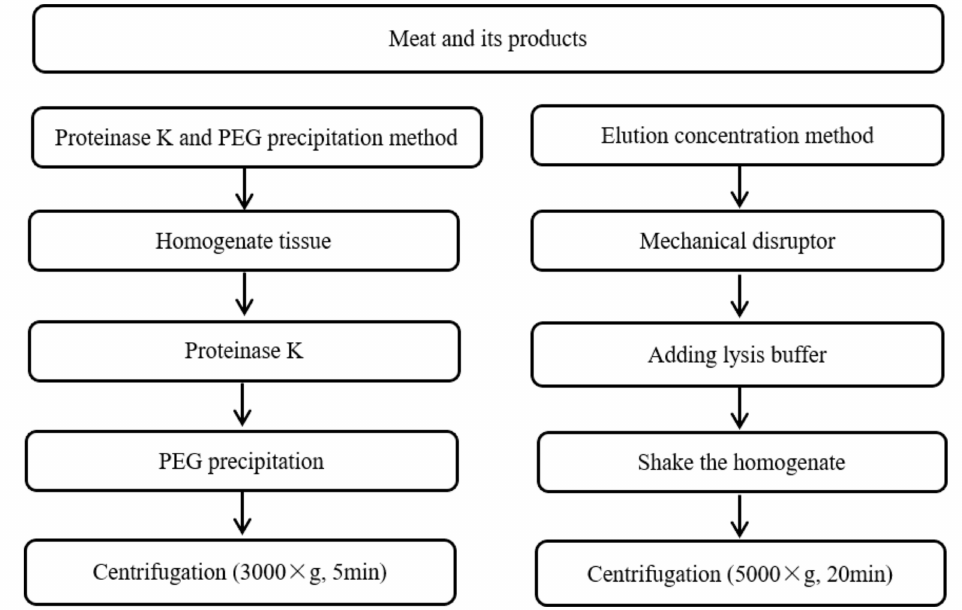
Figure 6. Summary of pre-treatment methods for nucleic acid determination of meat and its prod- ucts